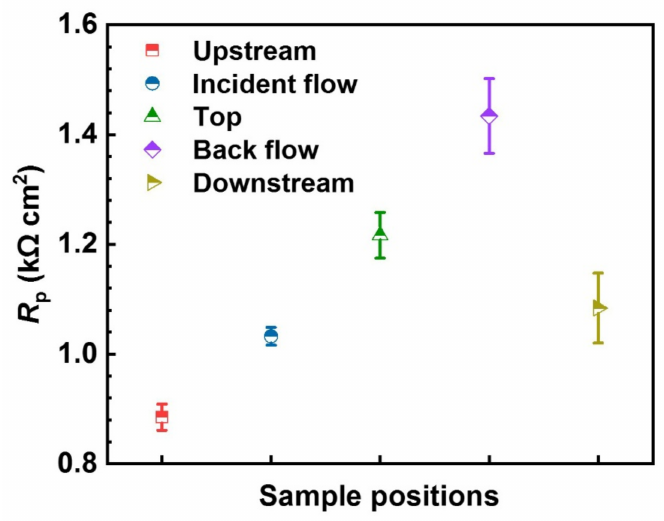
Figure 7. The polarization resistance ( R p ) of each sample on different WRH planes in the solution with a flow velocity of 2.3